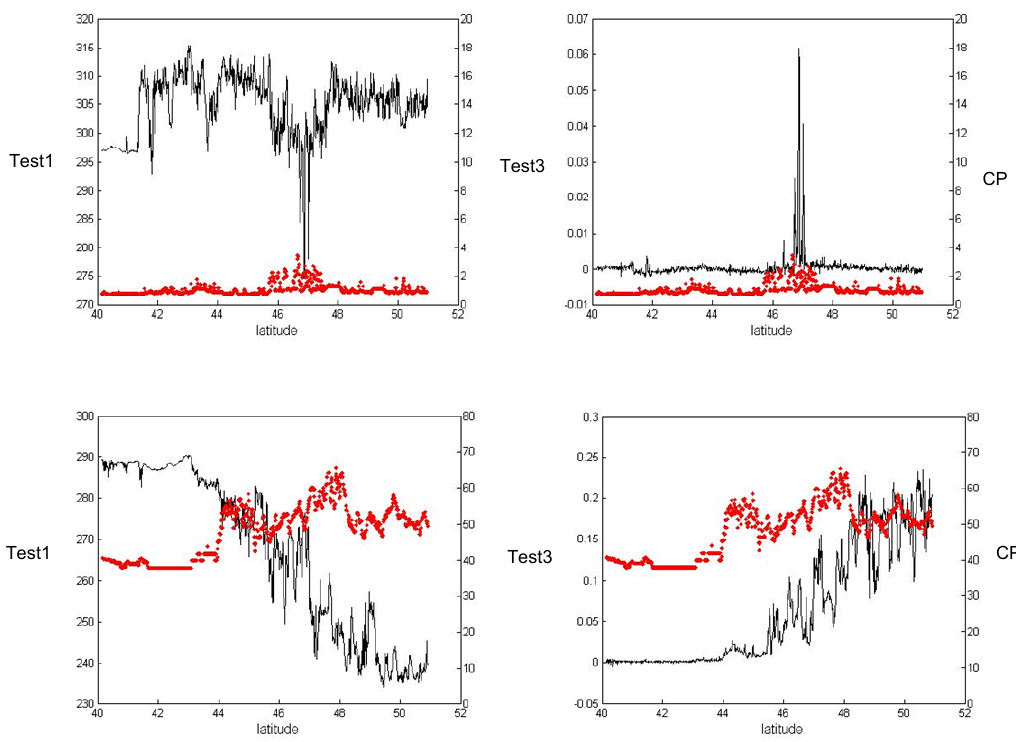
Figure 9. Comparison among the geo-located profiles of the tests 1 and 3 on MODIS data (black line) and the cloud profile (CP) detected by CALIPSO (red line). The first two images correspond to DOY 200 in 2006 characterized by cloud-free area and the second two images correspond to DOY 324 in 2006 characterized by extended cloud coverage.